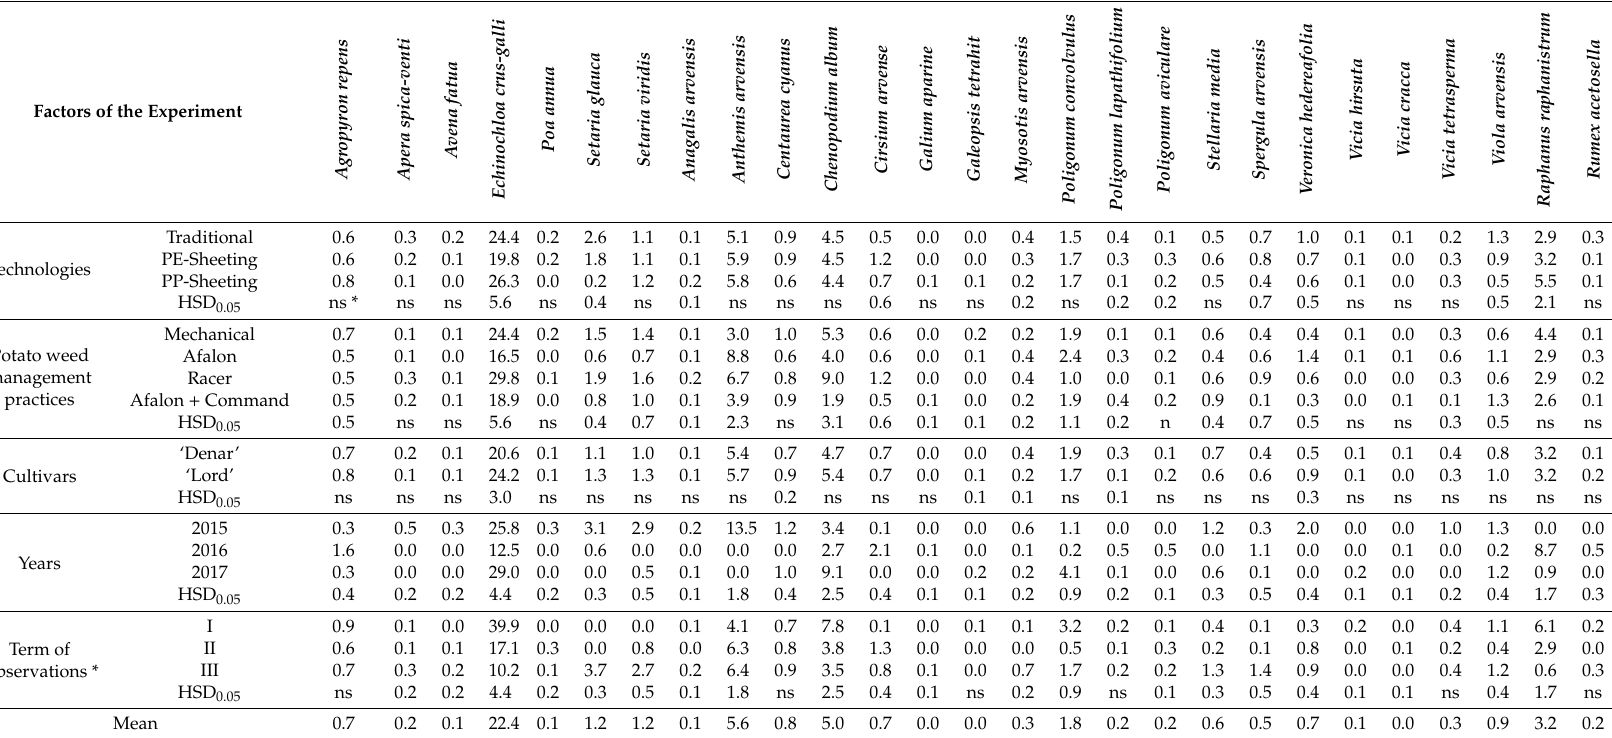
Table 9. Species composition and number of mono- and dicotyledonous weeds (pcs m − 2